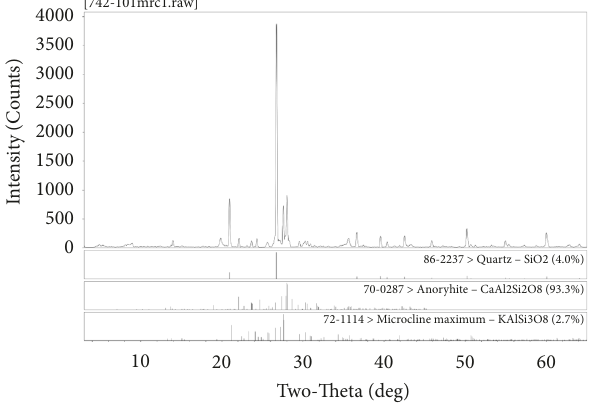
Figure 10: X-ray typical diffraction figure (86-2237 > Quartz-SiO2 (4.0%): PDF the card number > material composition-chemical formula (composition